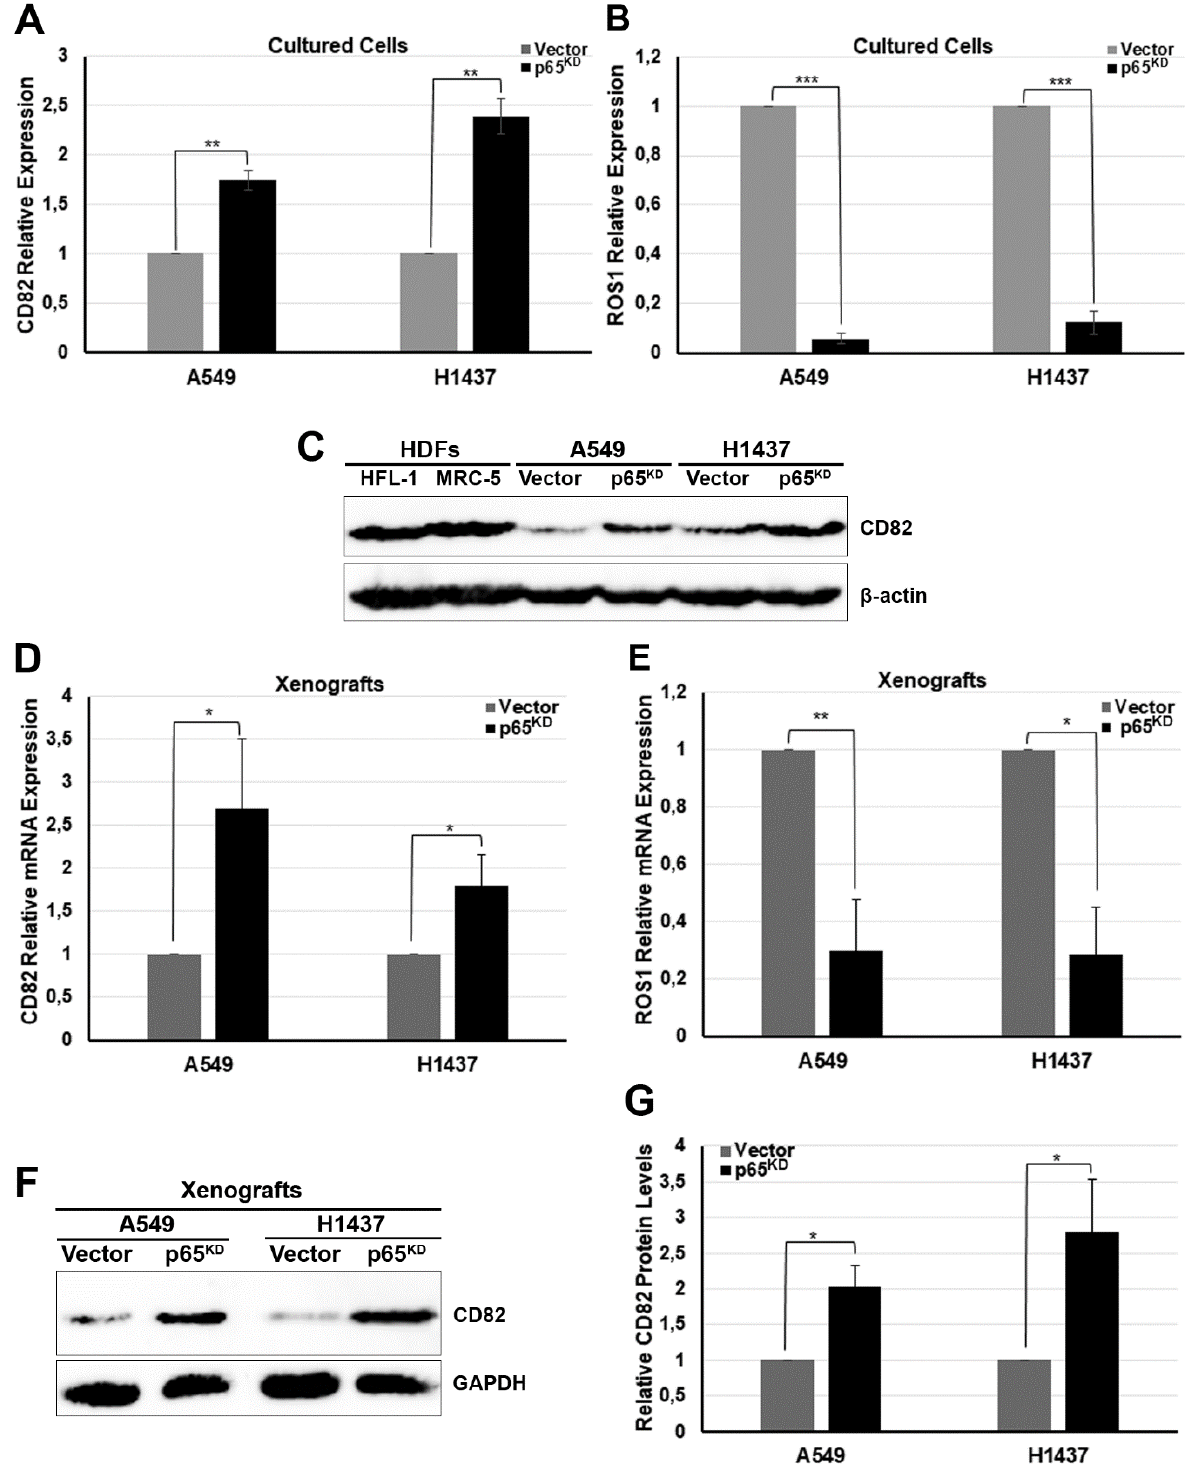
Figure 3. NF- κ B p65 regulates the expression of ROS1 and CD82 in vitro and in vivo. ( A , B ) Total RNA was isolated from vector control and p65 KD A549 and Η1437 human lung cancer cells grown in vitro and analysed for the expression of CD82 ( A ) or ROS1 ( B ) mRNA by qPCR ( n = 3). ( C ) Total protein lysates were isolated from normal lung HDFs, HFL-1 and MRC-5, and from vector control and p65 KD A549 and H1437 cancer cells grown in vitro and analysed for the expression of CD82 or β -actin as a reference control by immunoblotting. ( D , E ) Total RNA isolated from vector control and p65 KD A549 and H1437 cells grown as tumour xenografts in mice was analysed for the expression of ( D ) CD82 and ( E ) ROS1 mRNA by qPCR ( n = 3). RNA polymerase II was used as the reference control gene. ( F ) Total protein lysates were isolated from vector